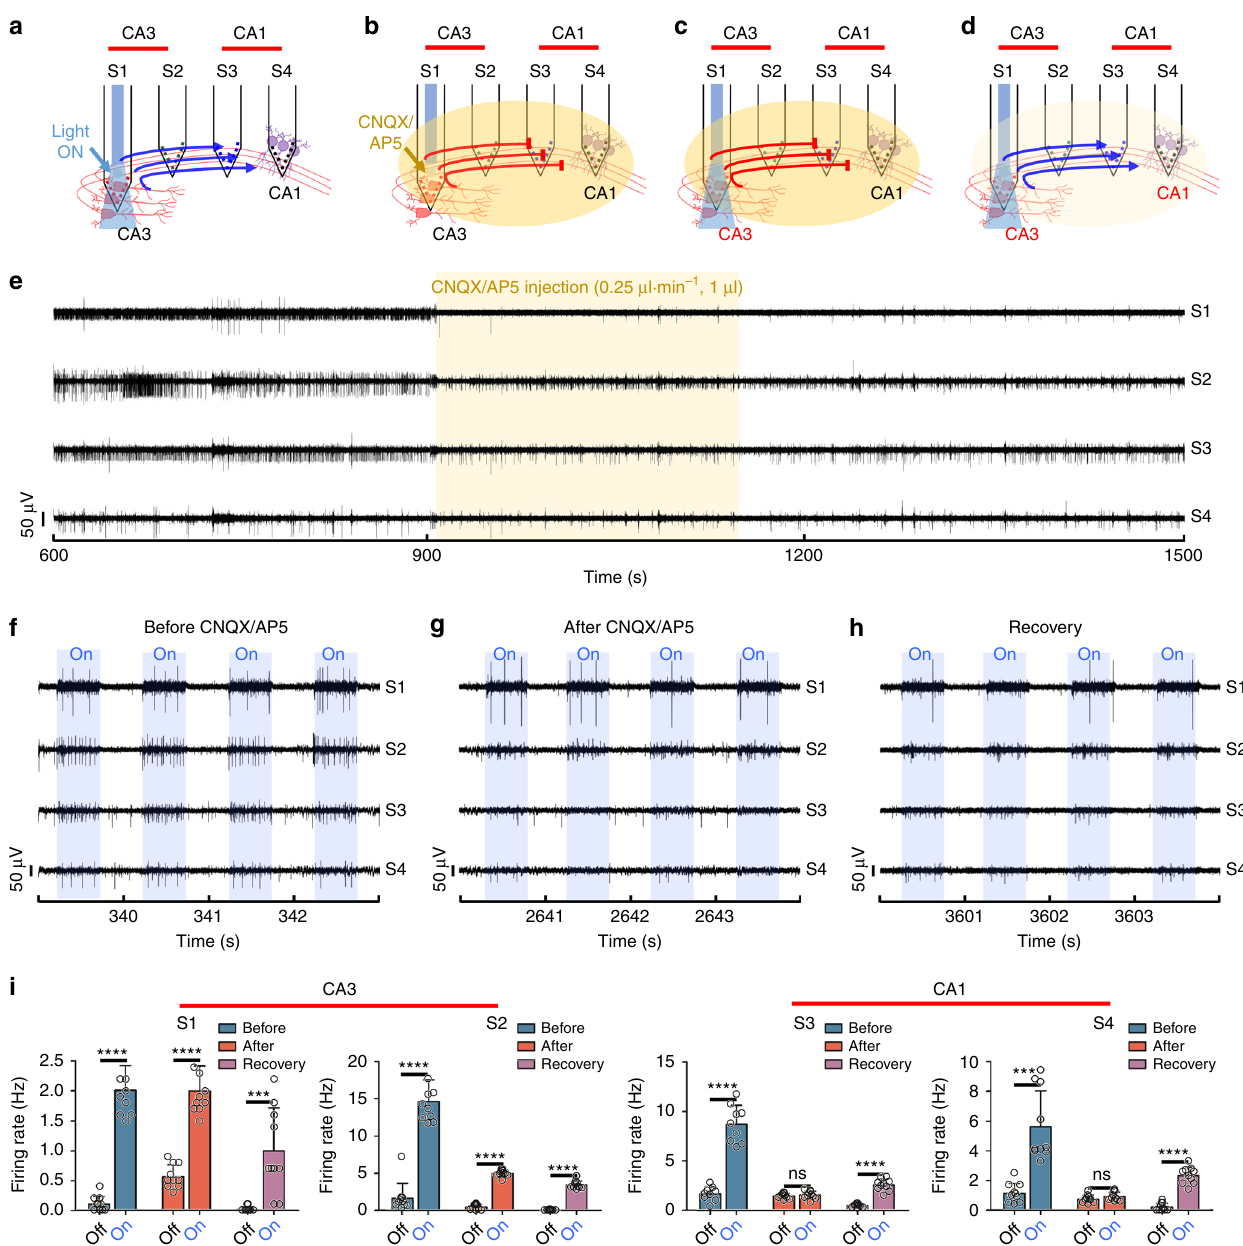
Fig. 4 Modulation of the neural circuit through the synapse blockage with drug delivery: a – d Conceptual diagrams of the experimental process: a The connectivity veri fi cation between hippocampal CA3 and CA1 by optical stimulation; b The synapse blockage between hippocampal CA3 and CA 1 by CNQX and AP5 injection; c The veri fi cation of blocking connectivity between hippocampal CA3 and CA1 by optical stimulation; d Recovery of connectivity by drug diffusion in the brain; e Representative transient plot during CNQX and AP5 injection at shank 1 (yellow mark indicates drug injection); f – h Transient plot during optical stimulation before and after CNQX and AP5 injection and recovery (the blue mark indicates light onset); i Comparison of the fi ring rate of the off cycle during optical stimulation and the on cycle during optical stimulation before and after CNQX and AP5 injection and recovery in hippocampal CA3 and CA1. Error bars indicate s.d. (S1: **** P < 0.0001, t t013.83(Before), **** P **0.0001, t t09.737(After), *** P *0.0004, t t04.337(Recovery), S2: **** P **0.0001, t t011.49(Before), **** P *0.0001, t t024.83(After), **** P *0.0001, t t019.7(Recovery), S3: **** P **0.0001, t t010.15(Before), ns P n0.5657 t t50.5852(After), **** P *0.0001, t t010.71(Recovery), S4: *** P *0.0001, t t05.755(Before), ns P n0.2046, t t21.316(After), **** P *0.0001, t t010.69 (Recovery). d.f. .f18 and n 8 10 for all, n 0 fi ring rate for 10 trials, Two-tailed t